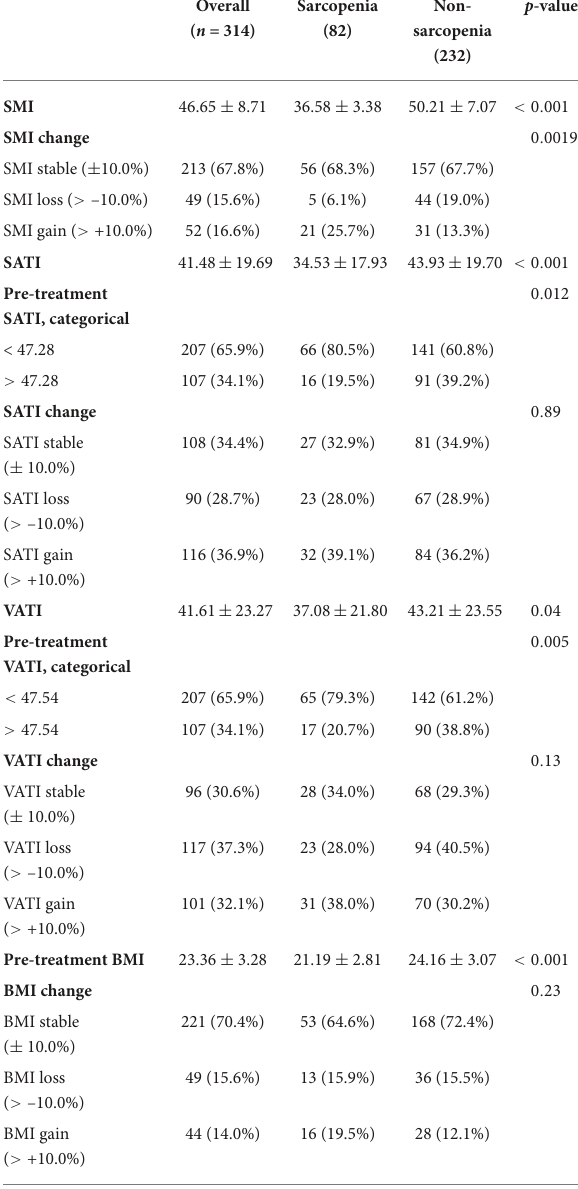
TABLE 2 The body composition changes during 6 months after surgery ( n =